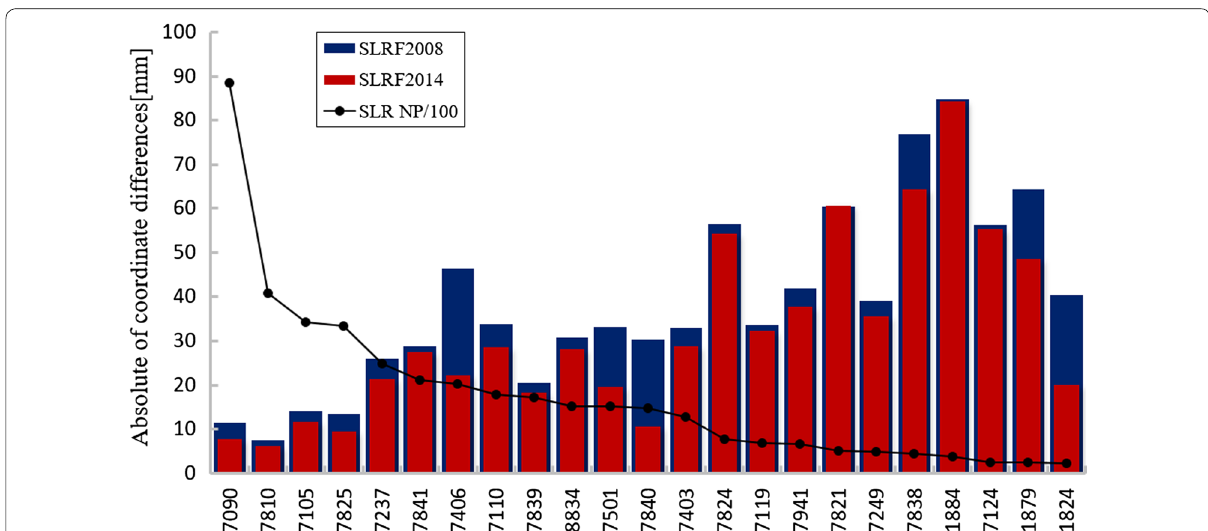
Fig. 4 Absolute of coordinate differences between the estimated SLR station coordinates and SLRF2008 and SLRF2014. The range bias corrections were applied in